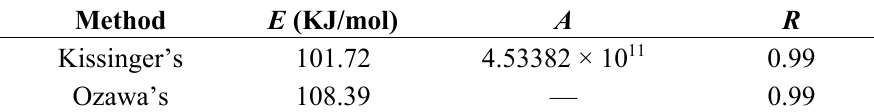
Figure 7. Relationship between lg β and 1/ T p . Table 4. Thermal reaction kinetic parameters of pretreated paraffin in O 2